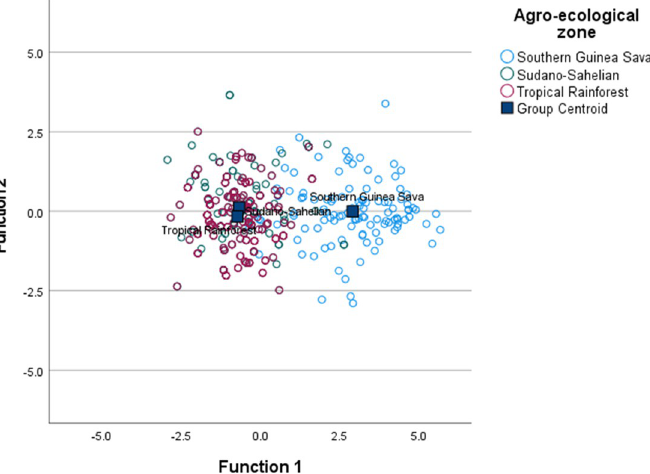
Fig 3. Canonical discriminant function illustrating the distribution of the Guinea fowls among the agro- ecological zones.